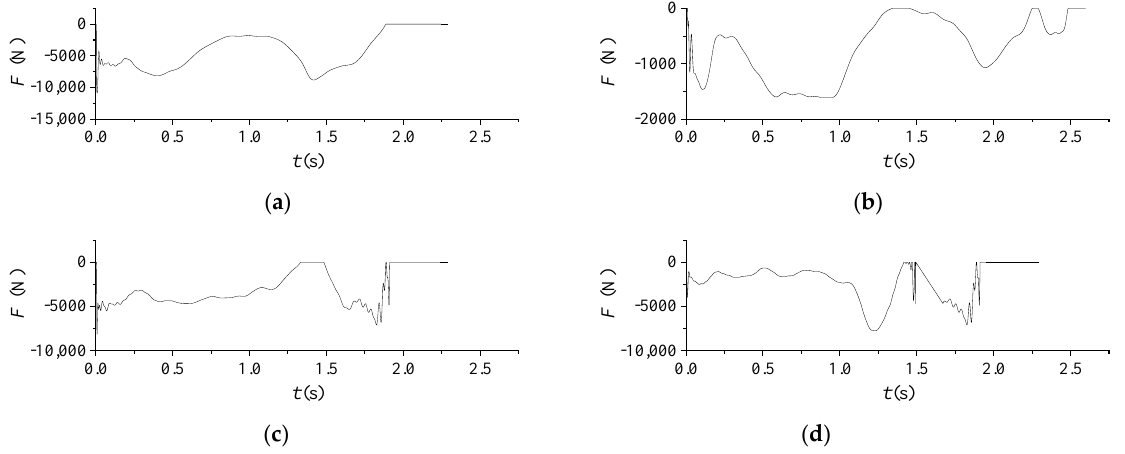
Figure 13. The contact force identification result of the 5 m span. ( a ) 5 km/h, ( b ) 10 km/h, ( c ) 15 km/h, ( d ) 20 km/h.